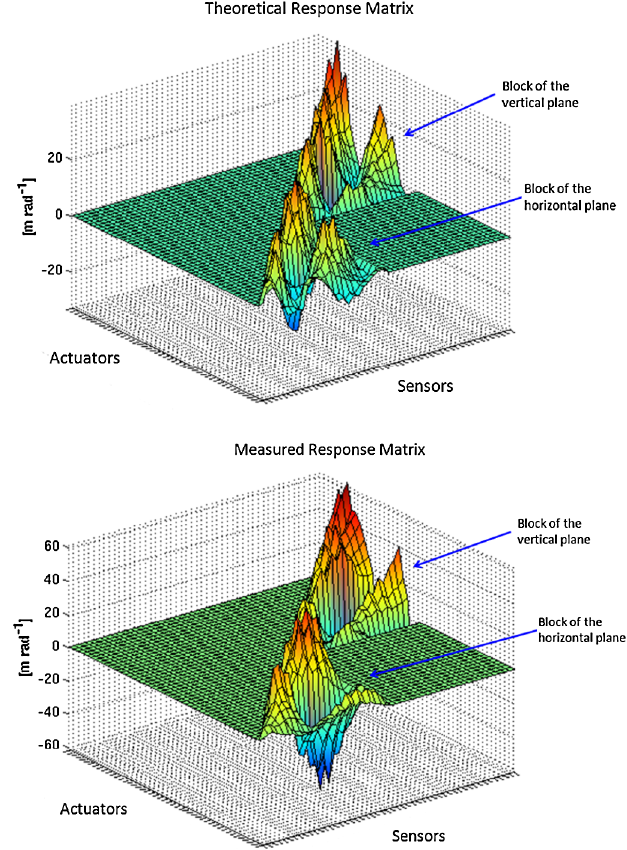
FIG. 8. Visualization of direct TRMs. Theoretical (top) and measured (bottom) TRM for the FERMI linac. The two diagonal blocks are for the horizontal and vertical plane, respectively. The ‘‘theoretical’’ TRM shown on the top is the merged version of a two-dimensional experimental TRM for the injector and of the theoretical TRM for the main linac. The merged matrix has been used for global trajectory correction in the FERMI linac, as shown in Figs. 9 and